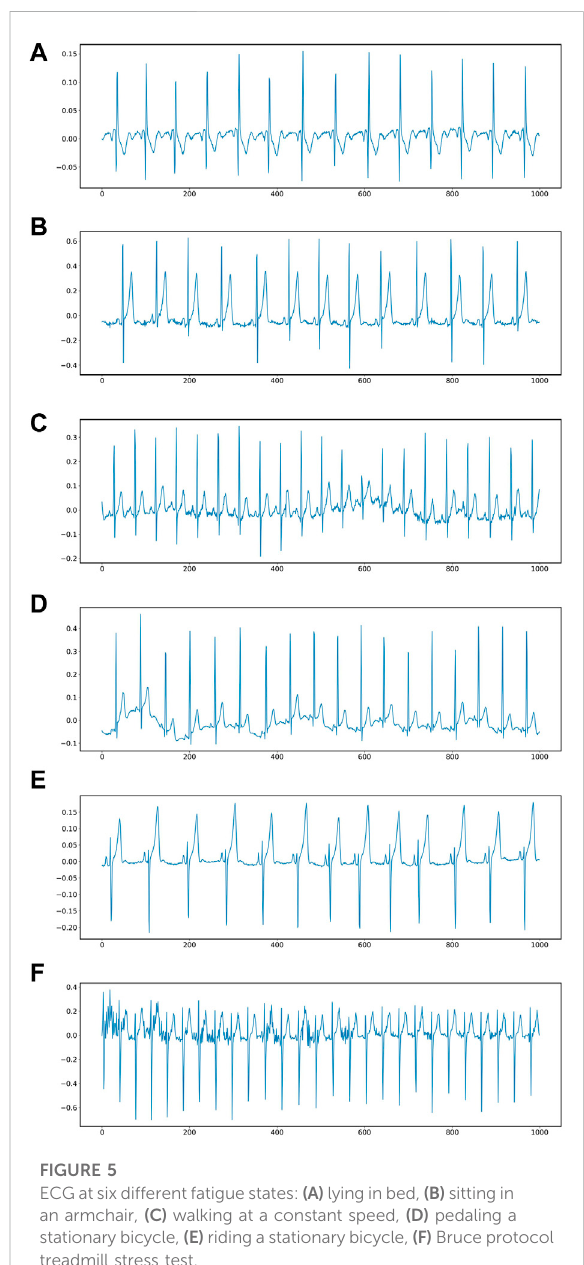
FIGURE 5 ECGatsixdifferentfatiguestates: (A) lyinginbed, (B) sittingin an armchair, (C) walking at a constant speed, (D) pedaling a stationary bicycle, (E) ridingastationarybicycle, (F) Bruceprotocol treadmill stress